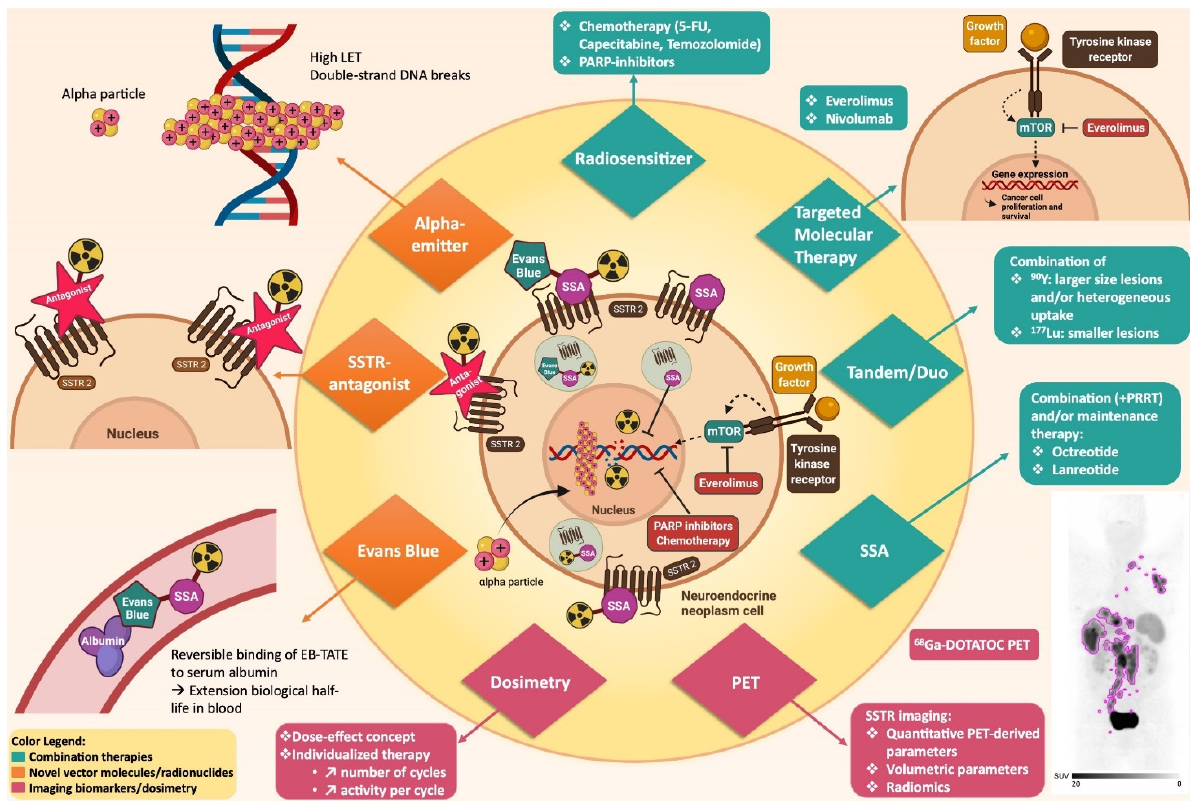
Figure 2. Optimization of PRRT. LET = linear energy transfer; SSTR = somatostatin receptor; SSA = somatostatin analogue; PRRT = peptide receptor radionuclide therapy; PARP = Poly ‐ [ADP ‐ ribose] ‐ polymerase; mTOR = mammalian target of rapamycin; 5 ‐ FU = 5 ‐ fluorouracil; PET = positron emission tomography.